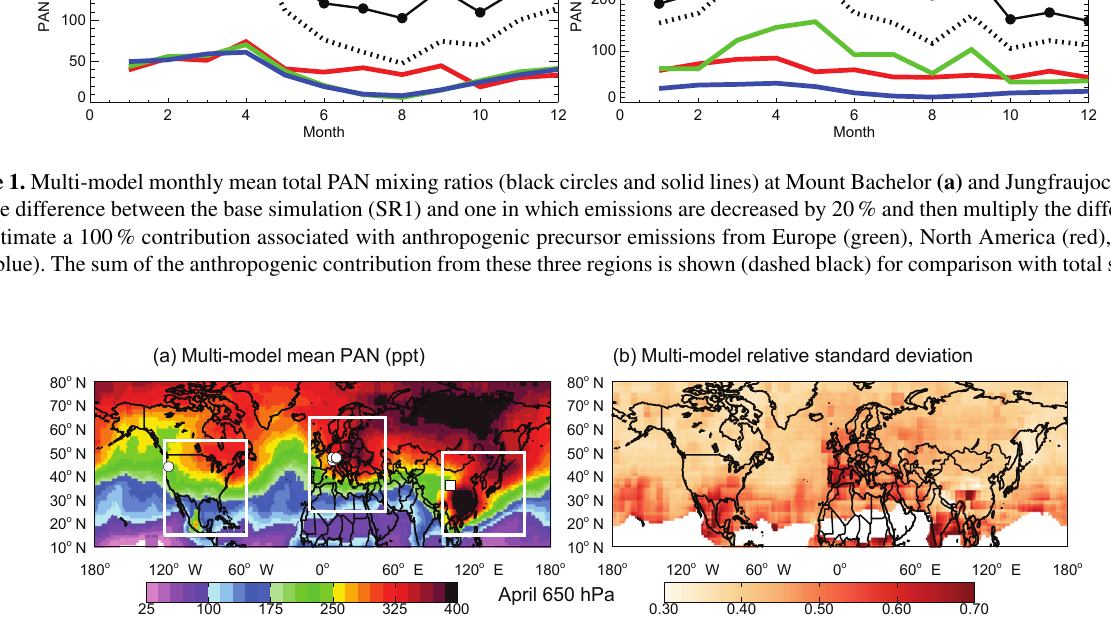
Figure 2. Multi-model ensemble ( n = 14; Table 1) average PAN mixing ratios (ppt; a ) and relative standard deviation (the absolute standard deviation across the models divided by the ensemble mean; b ) at 650hPa in April; relative standard deviations are masked out (white) for regions where multi-model mean PAN falls below 100ppt. The models were sampled at 650hPa by vertically interpolating among the bounding grid cells and then re-gridded horizontally to a common 1 ◦ × 1 ◦ grid. White lines denote the HTAP1 source regions: North America (NA), Europe and North Africa (EU), and East Asia (EA) from left to right. White circles indicate the five mountain sites with multiyear PAN observations used in our analysis (note that Zugspitze and Hohenpeissenberg are too close to differentiate on the map; see Table 3). Mount Waliguan in Asia, where we lack multiyear measurements but conduct model analysis, is denoted by the white